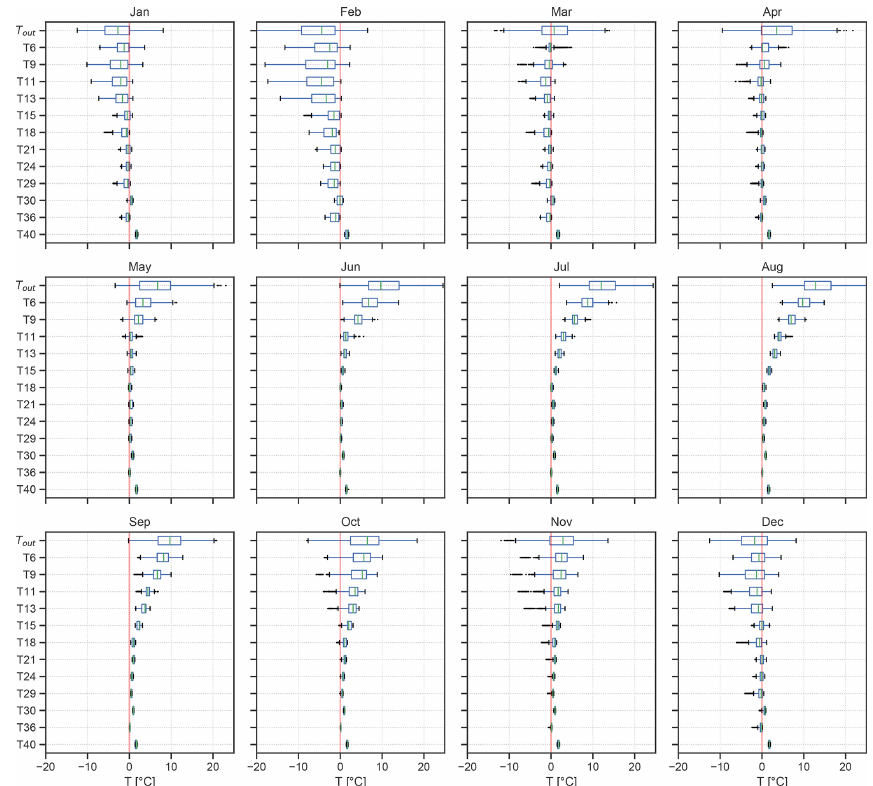
Figure 6. Monthly temperature variations for the period of July 2009 to May 2014. The different temperature loggers are plotted along the y axis from the top down, starting with the outside station ( T out ). The vertical red line marks the 0 ◦ C line. The boxes mark the interquartile range (IQR), whiskers mark the distance of 1.5 times the IQR, and the green line denotes the median.